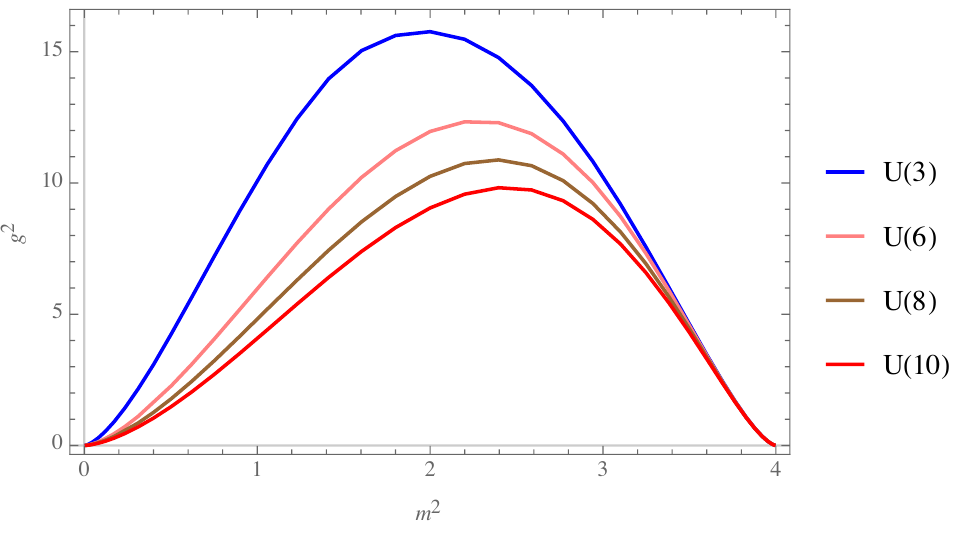
Figure 10 . Upper bounds on the coupling to a single adjoint bound state.